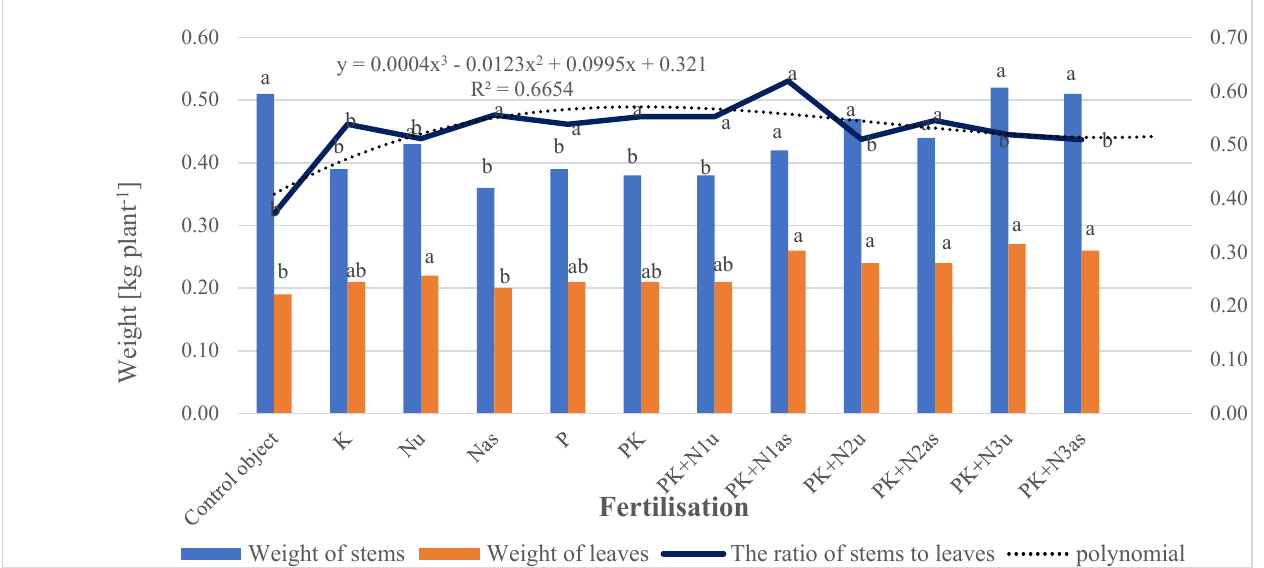
Figure 4. Leaf ‐ to ‐ stem ratios under the influence of mineral fertilization for H. tuberosus (2016–2018). Legend: control object ‐ N 0 P 0 K 0 ; P ‐ 43 kg P . ha − 1 ; K ‐ 124 kg K . ha − 1 ; as ‐ ammonium sulfate; u ‐ urea; Nu and Nas100 kg N . ha − 1 ; PKP 43 K 124 ; N1 ‐ 50 kg N . ha − 1 ; PK+N1N 50 P 43 K 124 ; N2100 kgN . ha − 1 ; PK+N2N 100 P 43 K 124 ; N3150 kg N . ha − 1 ; N3+PKN 150 P 43 K 124 kg ha − 1 . Letter indicators (a, b, etc.) next to